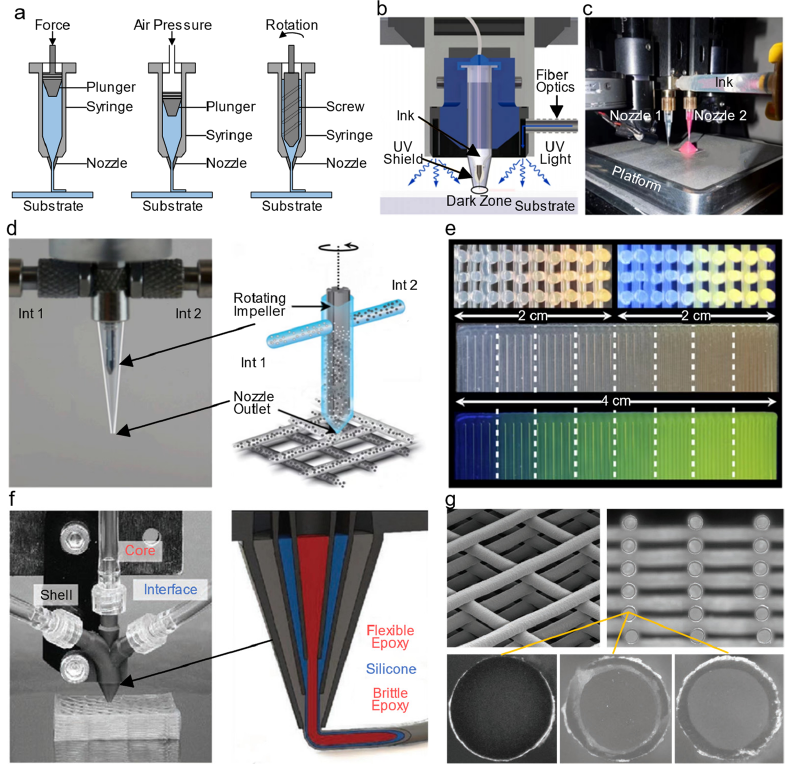
Figure 7. ( a ) Schematics of plunger-based extrusion, pneumatic-based extrusion, and screw-based extrusion of DIW. ( b ) Cross sectional view of the UV-assisted DIW process [128]. ( c )